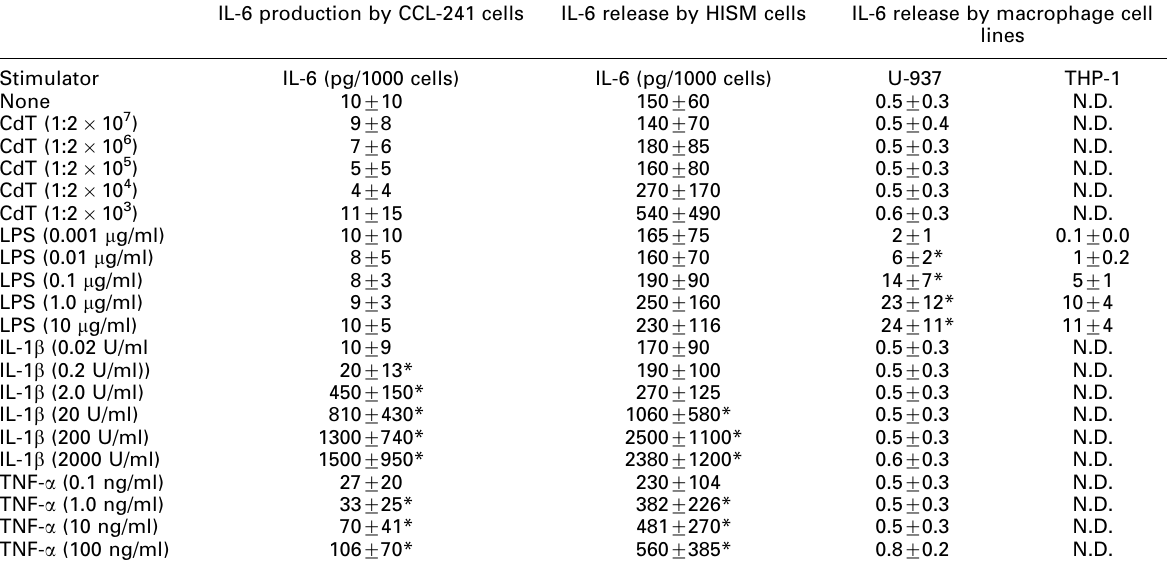
Table 1. Effects of various stimuli on IL-6 production by CCL-241 cells, and on IL-6 release by HISM cells and by macrophage cell lines IL-6 production by CCL-241